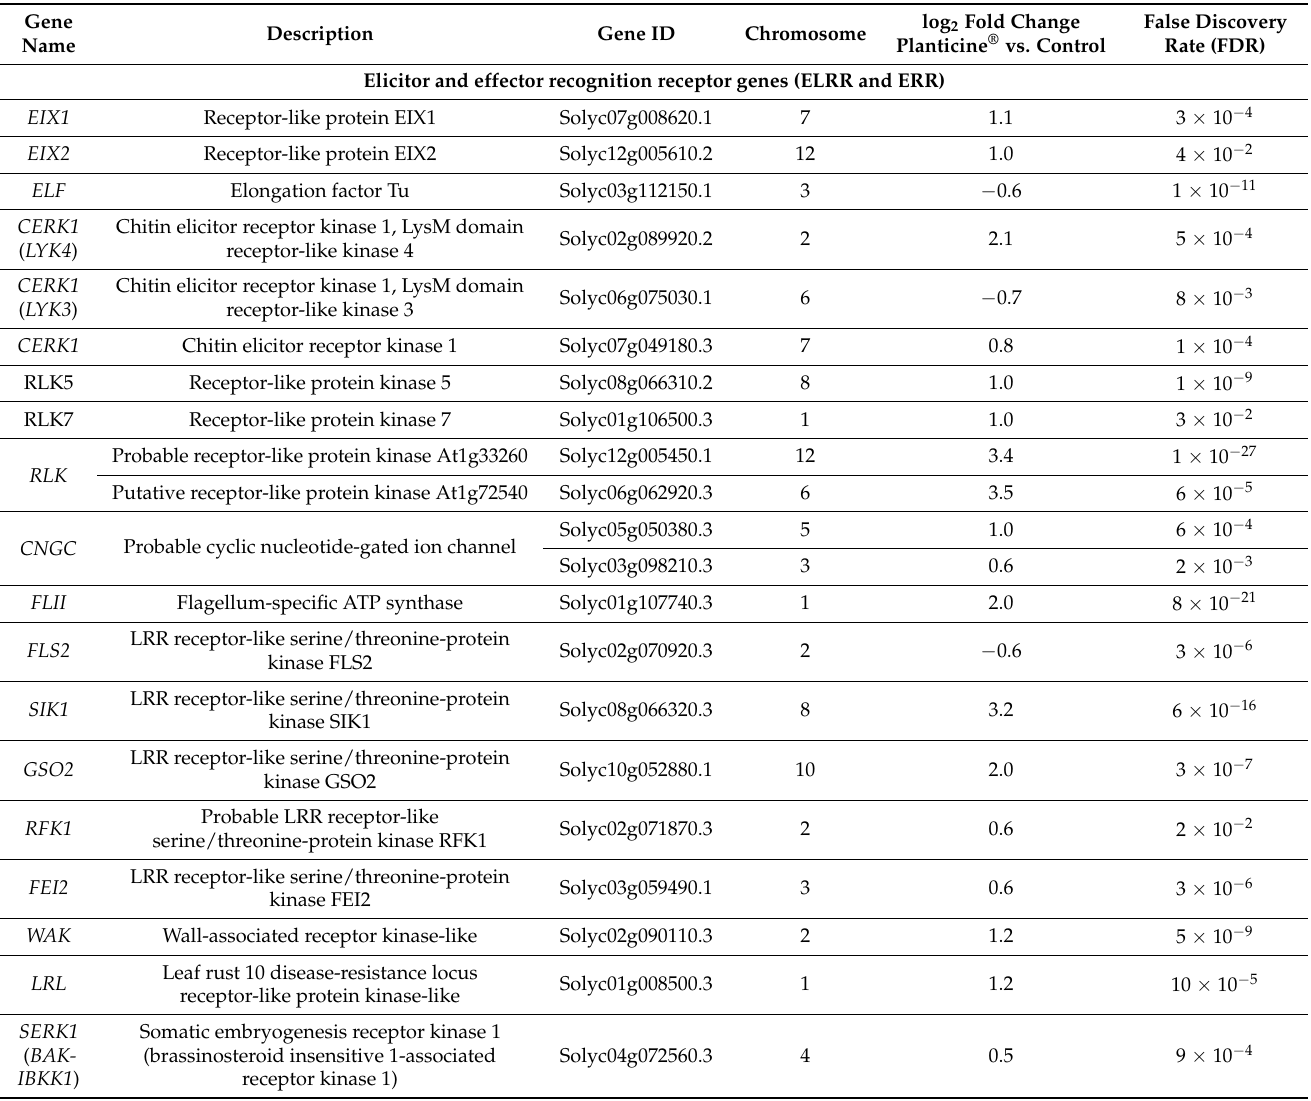
Table 1. Resistance genes, including regulatory (ELLR, ERR, MAPK, TF) and resistance-related protein (RRP) and resistance-related metabolite (RRM) biosynthesis genes, differentially expressed in tomato leaves under Planticine ®